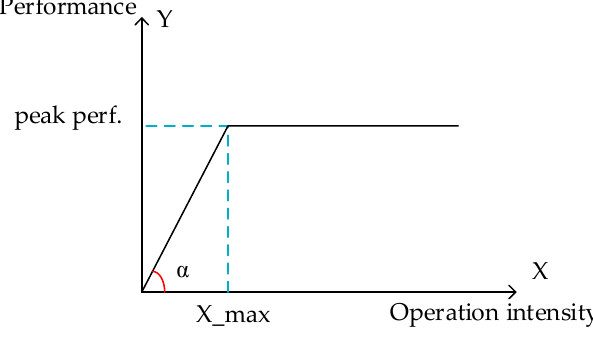
Figure 9. Roofline model.